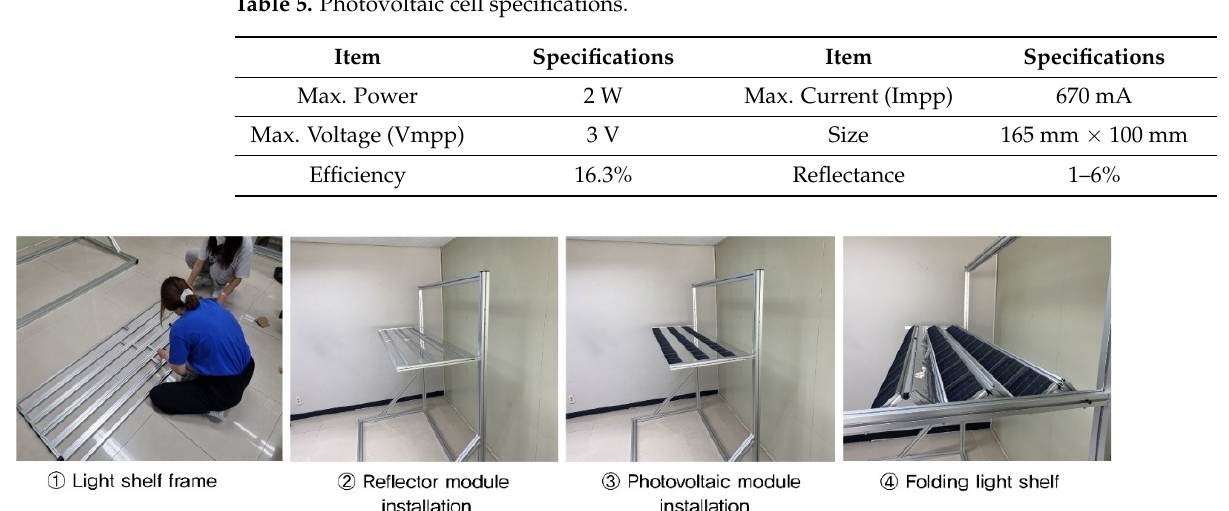
Figure 6. Light shelf fabrication for performance evaluation.